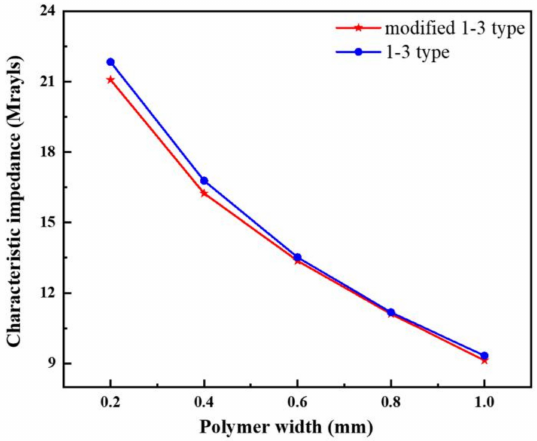
Figure 11. Characteristic impedance curve of two types of